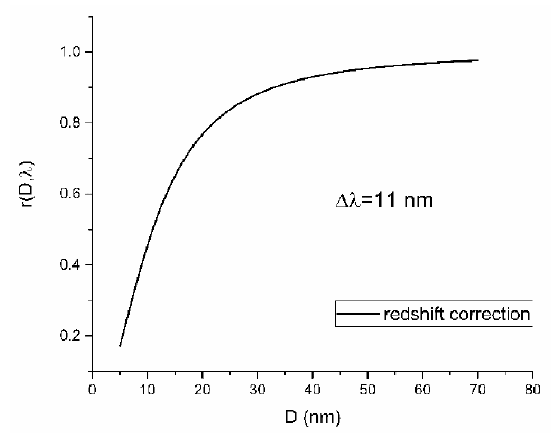
Figure 1. Redshift function vs. diameter of nanoparticles for K = 1 and fixed ∆ λ . Since the fitting function describes the dependence of absorbance on the wavelength, that is, the UV-Vis spectrum, the independent variable is wavelength. Since both extinction cross section and concentration depend on the diameter of nanoparticles, it is necessary to model diameter by wavelength variable in order to have correct dependence of absorbance on wavelength. It can be done by defining D j = D · λ where D is an unknown and undefined diameter value which is not important as a result of a fitting function. Notice that diameter stands as a variable in extinction cross section as well as in concentration and redshift function. It seems that the diameter value that stands as extinction cross section and concentration is not the same as in the redshift function. In the redshift function, the inverse diameter value is modeled and is written as D i = D · λ 0 . Moreover, the redshift function is modified Lorentzian in form r ( D i , λ ) = K · D . Qualitatively, reciprocal dependencies of modeled diameters in the extinction cross section and the log-normal distribution opposite to the redshift function implies the following. Since the modeled diameter in the redshift function regulates the width of the Lorentzian, it seems that for small values of diameter D j in the extinction cross section and log-normal distribution, diameter D i in the redshift function is reciprocally larger, meaning that for nanoparticles of small sizes, the spectral linewidth is reciprocally larger in accordance with [28]. Since all parameters in a fitting function are physical and defined, the same applies for parameter K. The physical explanation of the redshift constant K is that it represents a shift in wavelength by diameter unit and depends on nanoparticle material dielectric properties, size as well